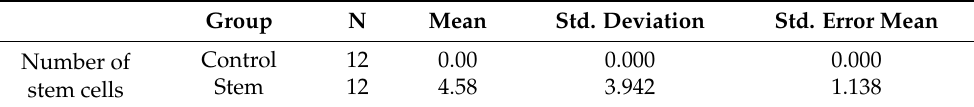
Table 4. MSC Group Statistics.